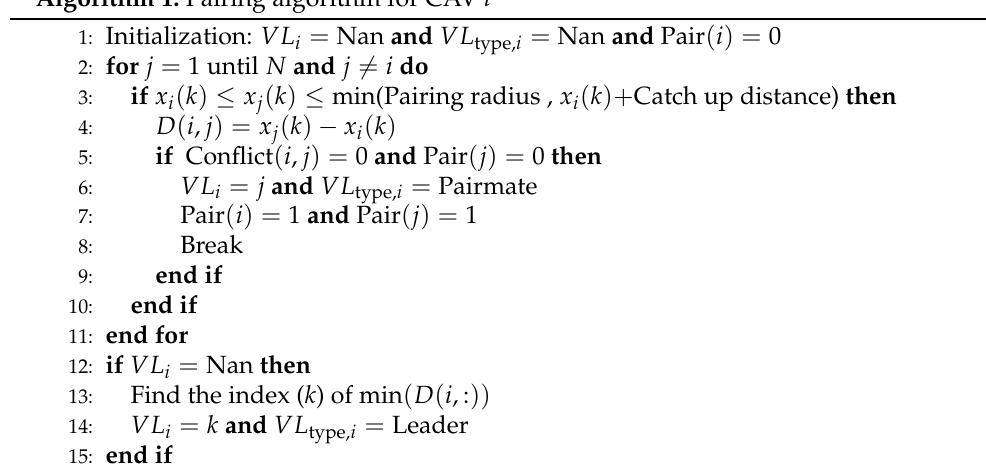
Algorithm 1: Pairing algorithm for CAV i